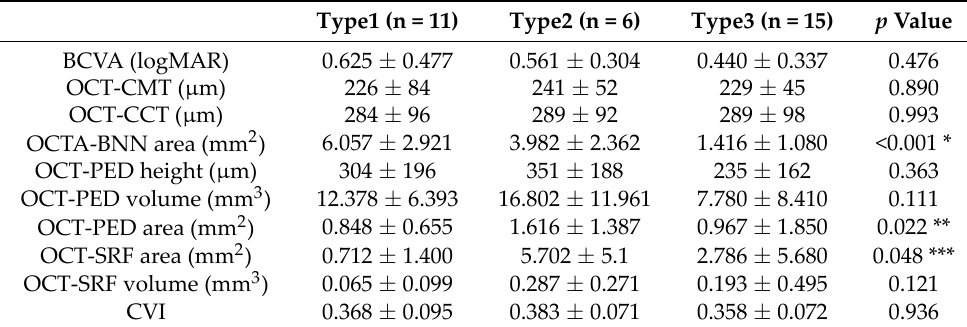
Figure 3. En face scan of OCTA showed a large BNN with a main stem in type 1 BNN ( A ). A clear break was shown on B‑scan OCT corresponding to the location of the origin of the BNN on en face OCTA (yellow arrow, ( B )). Blue lines showing the corresponding segmentation of PED layer ( C ). En face scan of OCTA demonstrating BNN without a main stem ( D ). The line representing Bruch’s mem‑ brane on OCT was irregular but without a clear break (yellow arrow, ( E )). Blue lines showing the corresponding segmentation of PED layer ( F ). En face scan of OCTA demonstrating BNN without a main stem ( G ). The Bruch’s membrane slightly curved toward the choroid layer and became increas‑ ingly obscure ( H ). Blue lines showing the corresponding segmentation of PED layer ( I ). 图像平均 , average image; 索引 , index. T, temporal; N, nasal. Table 2. Characteristics at 12 months among 3 PCV